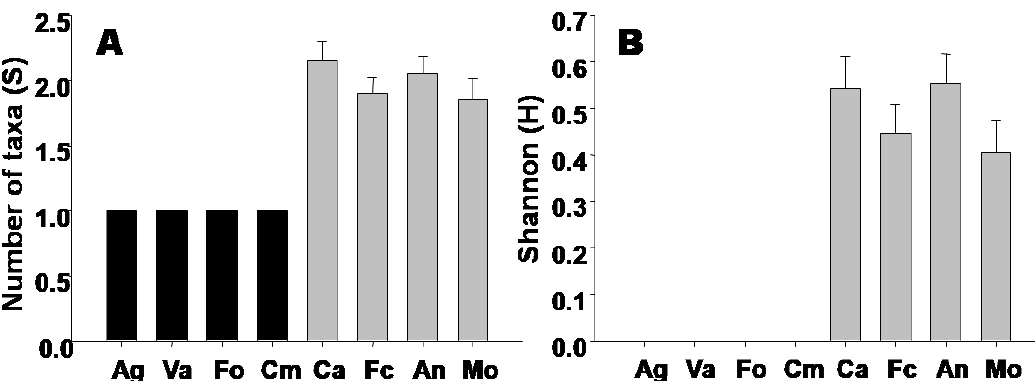
Figure 2. Values (+SE) of ( A ) number of taxa and ( B ) Shannon index for all the studied rocky shores: Aguda (Ag), Valadares (Va), Foz (Fo), Cabo do Mundo (Cm), Carreço (Ca), Forte do Cão (Fc), Âncora (An) and Moledo (Mo).